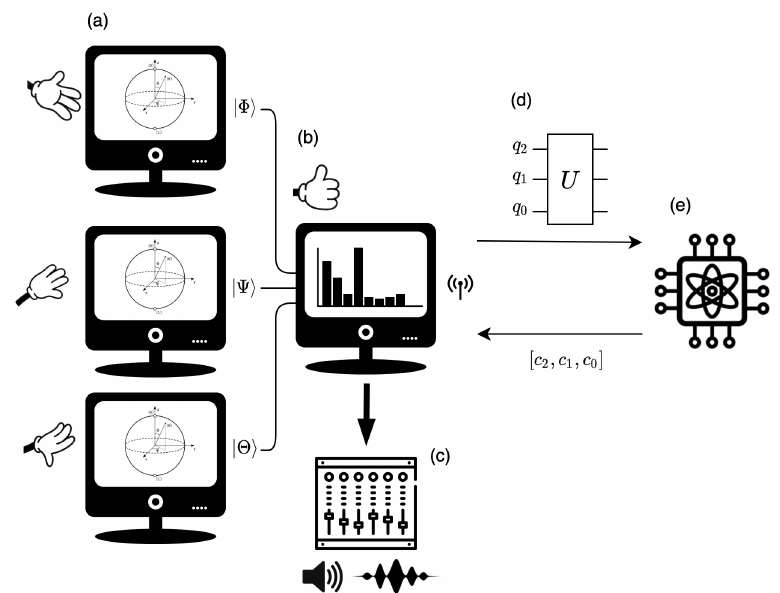
Figure 7. Three networked Q1Synth instruments for the performance Spinnings . Three Q1Synth units ( a ) are networked in a star topology with an additional machine ( b ) acting as a hub. The hub builds a quantum circuit expressing the current status of the simulated state vector ( c ) and sends the circuit to the quantum computer ( d ) for measuring. The hub informs each instrument of its respective outcome and synthesises the ‘measurement sound’ ( e ).